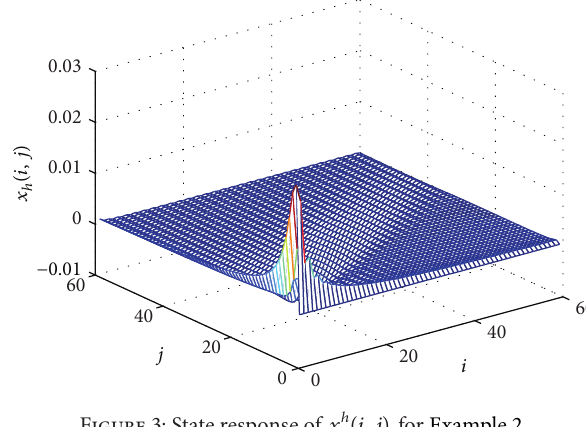
Figure 3: State response of 𝑥 ℎ (𝑖,𝑗) for Example 2.